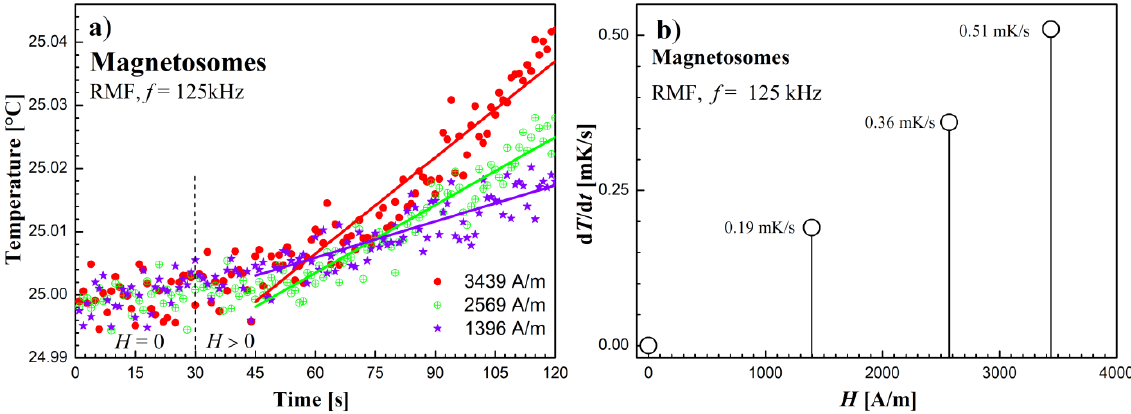
Figure 6. ( a ) Time courses of temperature changes in the Dextran FF sample. ( b ) d T /d t values depending on the amplitude of the magnetic field strength H in the RMF at the frequency f = 122 kHz. As shown in Figure 6b, in the magnetic fluid sample of dextran-coated nanoparti- cles, there is mainly a relaxation mechanism of heat energy release according to the Néel mechanism. This fact is proved by the value of the exponent n = 1.97, close to 2, which is characteristic of superparamagnetic nanoparticles lacking magnetic hysteresis [30].